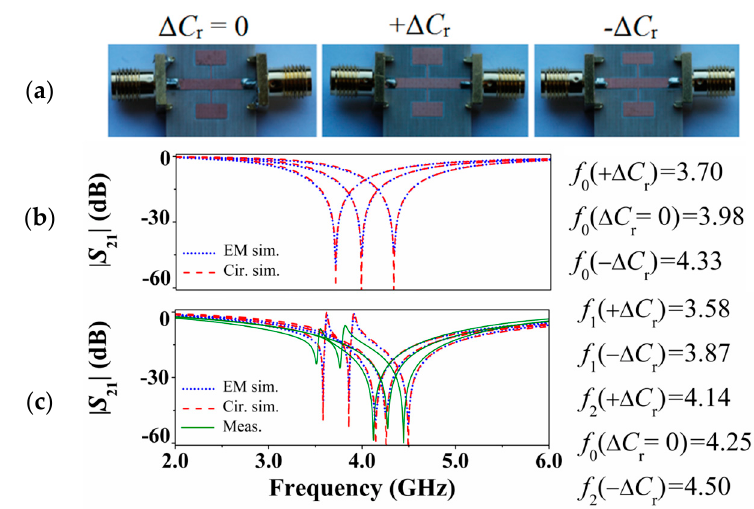
Figure 4. ( a ) Photograph of the fabricated SISS-loaded transmission lines, and transmission coefficient corresponding to the lossless electromagnetic and circuit simulations for a microstrip line loaded ( b ) with a single SISS (not fabricated), and ( c ) with a pair of SISSs (fabricated and shown in Figure 4a). In ( c ), measurements are included. The dimensions (in reference to Figure 2a) are W = 1.83 mm, l = 15.9 mm, l 1 = l 2 = l 3 = l 4 = 2.6 mm, Δ l 1 = ±0.5 mm, W 1 = W 3 = 5.5 mm, W 2 = W 4 = 250 µm. The substrate is Rogers RO4003C with considered dielectric constant ε r = 3.1, thickness h = 812.8 µm, and loss tangent tan δ = 0.0021. The circuit values are L = 1.80 nH, C = 0.57 pF, L r =2.46 nH, C r = 0.65 pF, ± Δ C r = ±0.15 C r = ±0.10 pF, and M = − 0.31 nH. Reprinted with permission from [9].